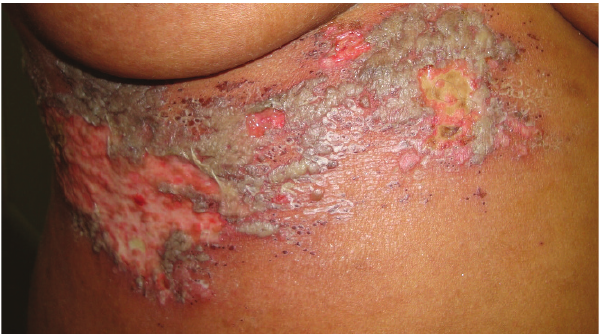
Figure 1 - Grouped erythematous vesiculous and crusted herpes zoster lesions on the right thoracic region along the intercostal nerve path.